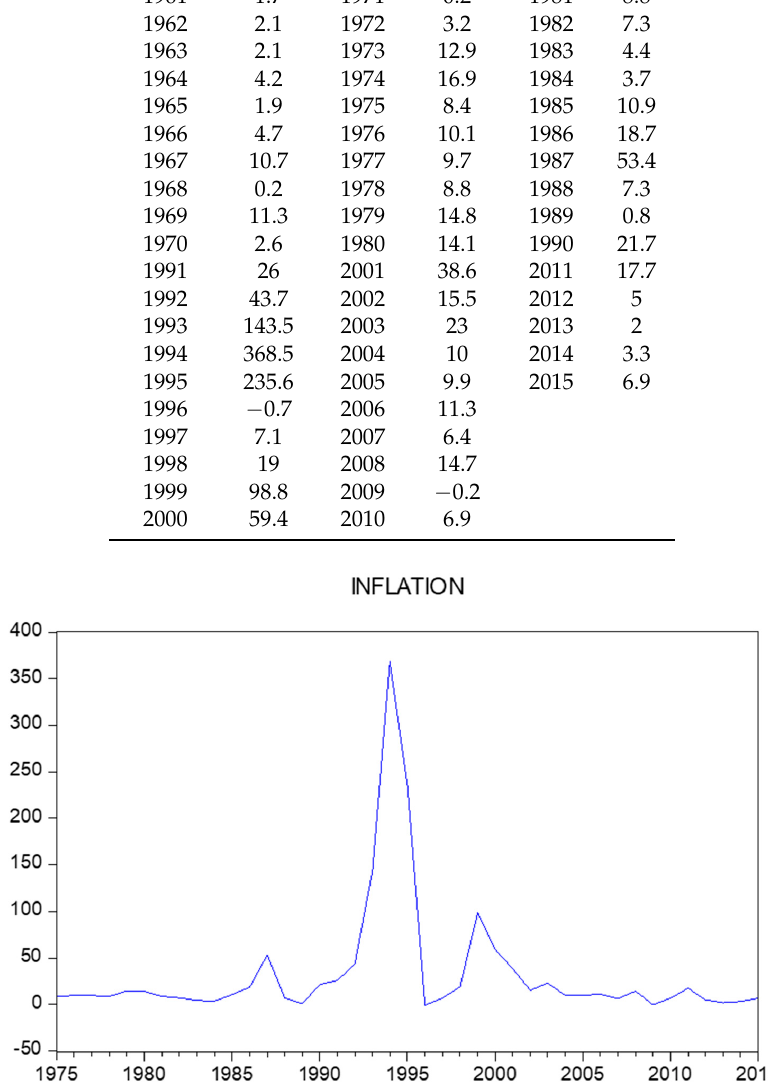
Figure 2. Inflation (in yearly percentages) in Suriname.